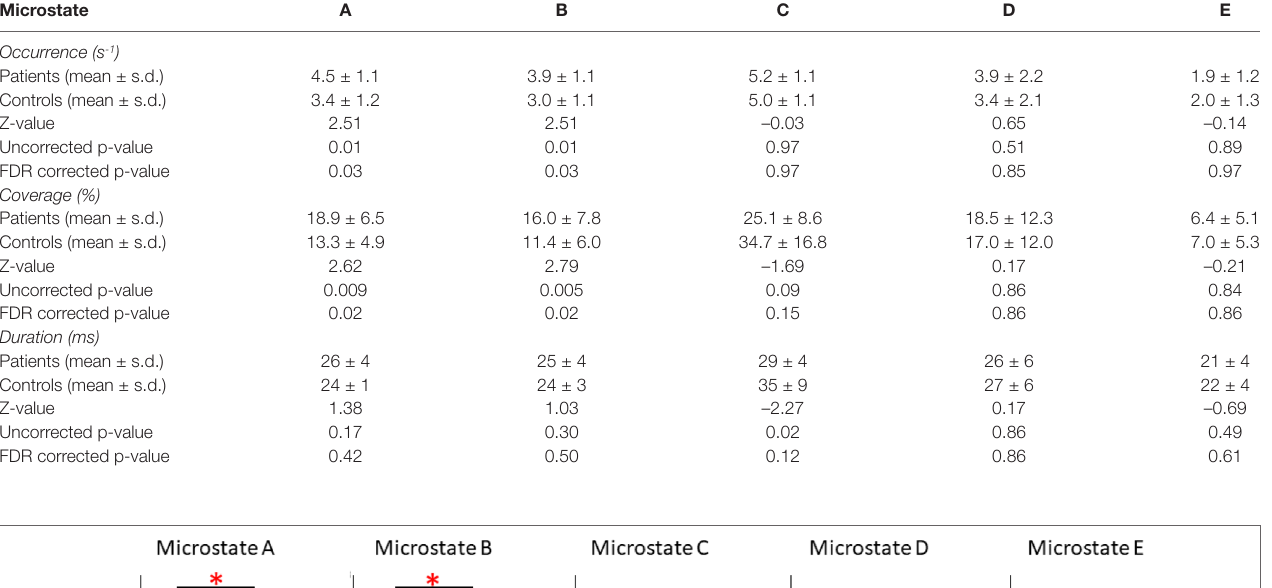
TABLE 2 | Mann-Whitney U test for group comparisons in the investigated microstate parameters. Microstate A B C D E Occurrence (s -1 ) Patients (mean ± s.d.)